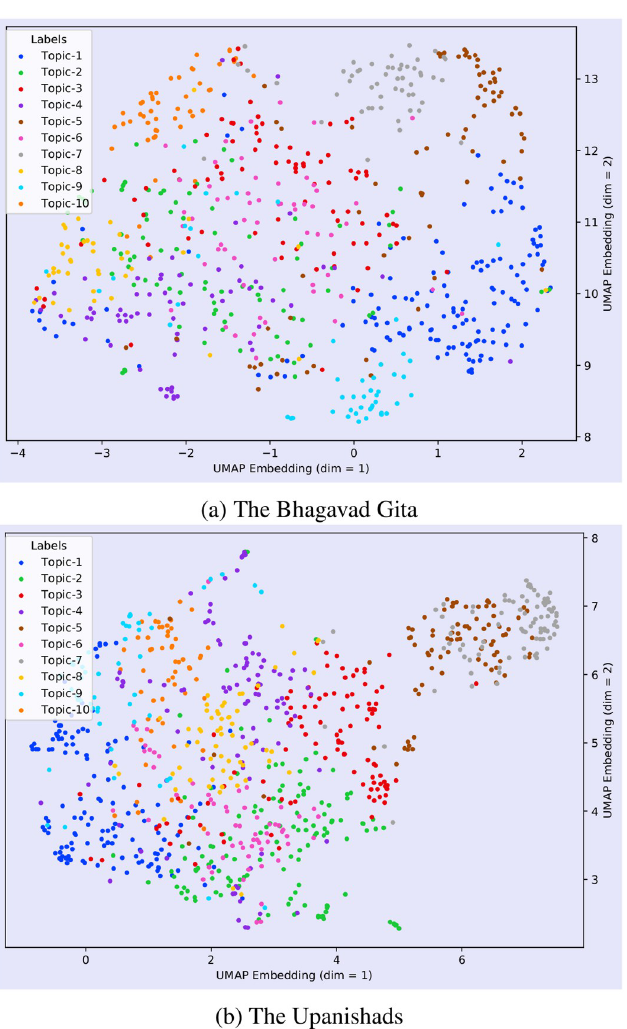
Fig 8. Visualization of the semantic space of the Bhagavad Gita (Eknath Easwaran) and the Upanishads (Eknath Easwaran) with topic labels.